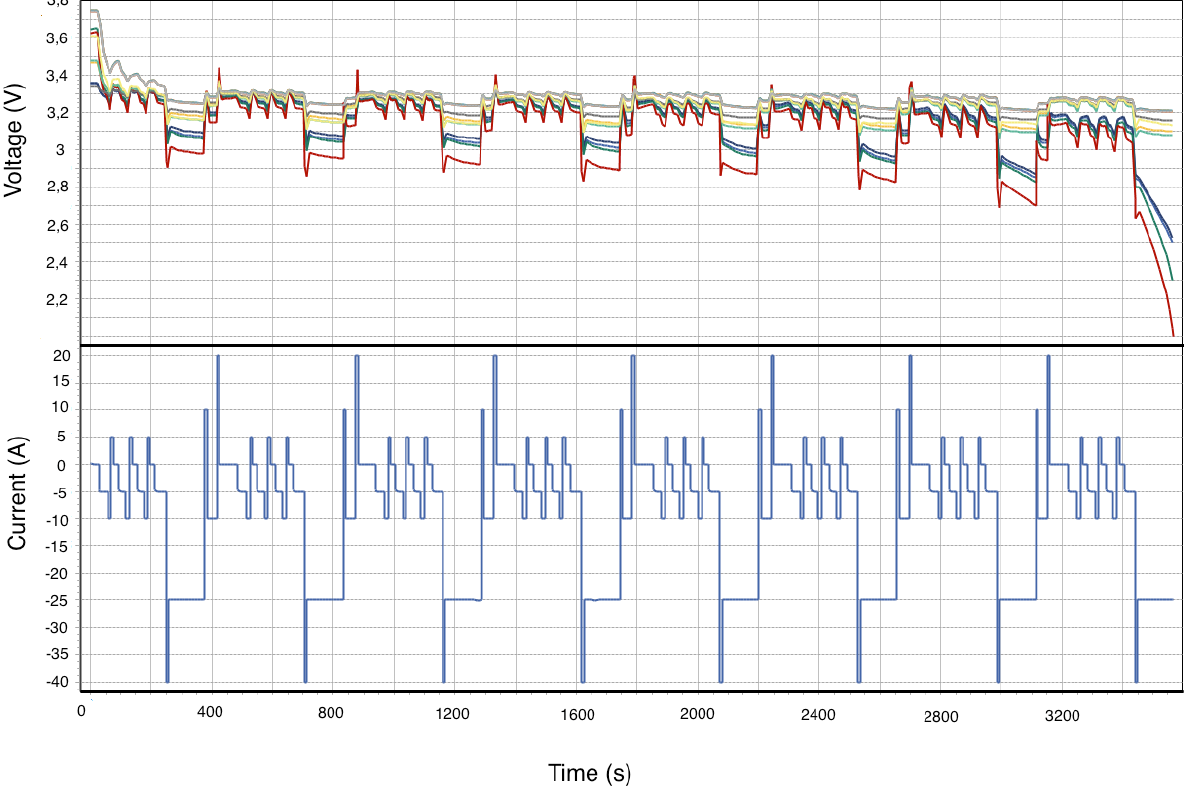
Figure 13. Experimental results of the Punch topology.